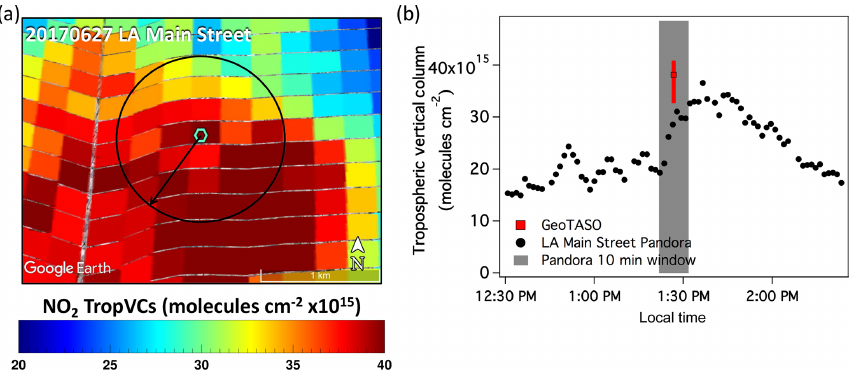
Figure 6. (a) Map of GeoTASO TropVCs on a linear color scale for the LA Main Street overflight on 27 June 2017 at 20:26UTC (13:26LDT) (cyan triangle in Fig. 3) with the 750m radius considered in the spatial binning of GeoTASO overlaid and an arrow depicting the Pandora viewing direction (solar azimuth angle). The Pandora hexagon is colored by the NO 2 TropVC measured by Pandora during the overpass. (b) Time series showing Pandora data (black points) within approximately ± 1h of the GeoTASO overpass. The Pandora temporal window for the coincidence is shaded in gray, and the GeoTASO TropVC and 10th–90th percentiles from the overpass are shown in red. Base map created in ©Google Earth